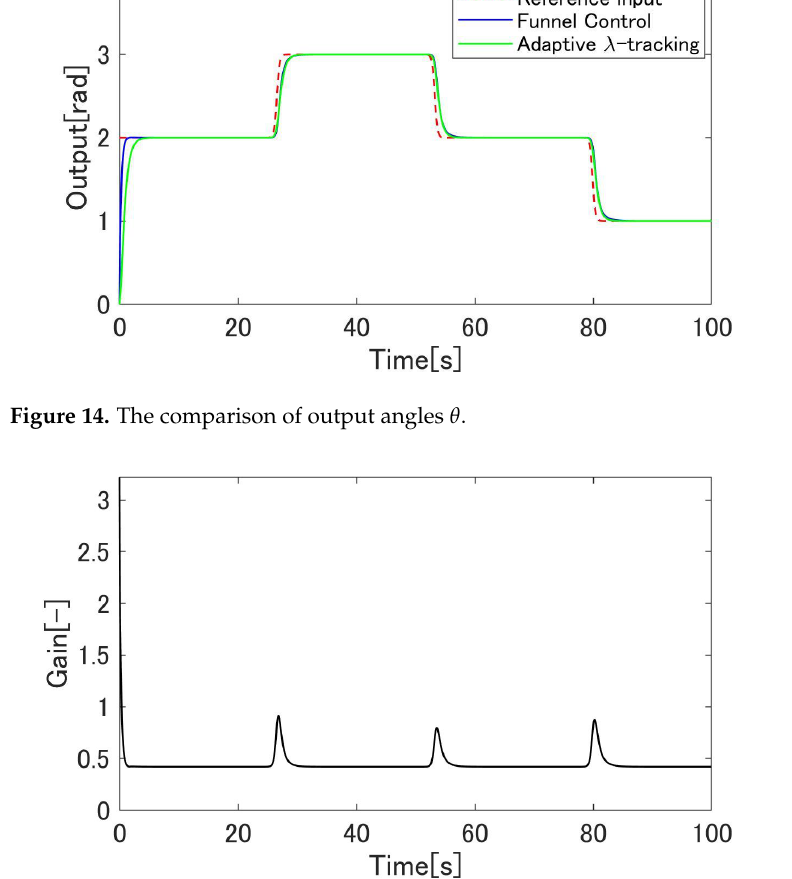
Figure 15. The gain κ of the proposed